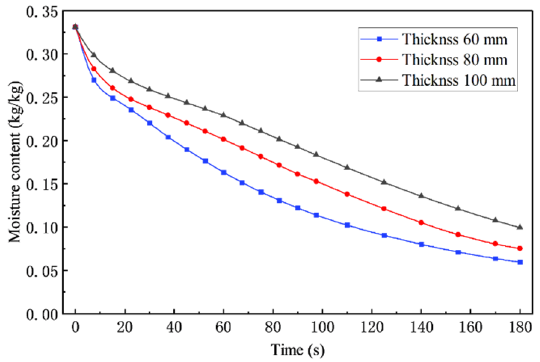
Figure 5. Overall average moisture content of the heaped tobacco strips models.